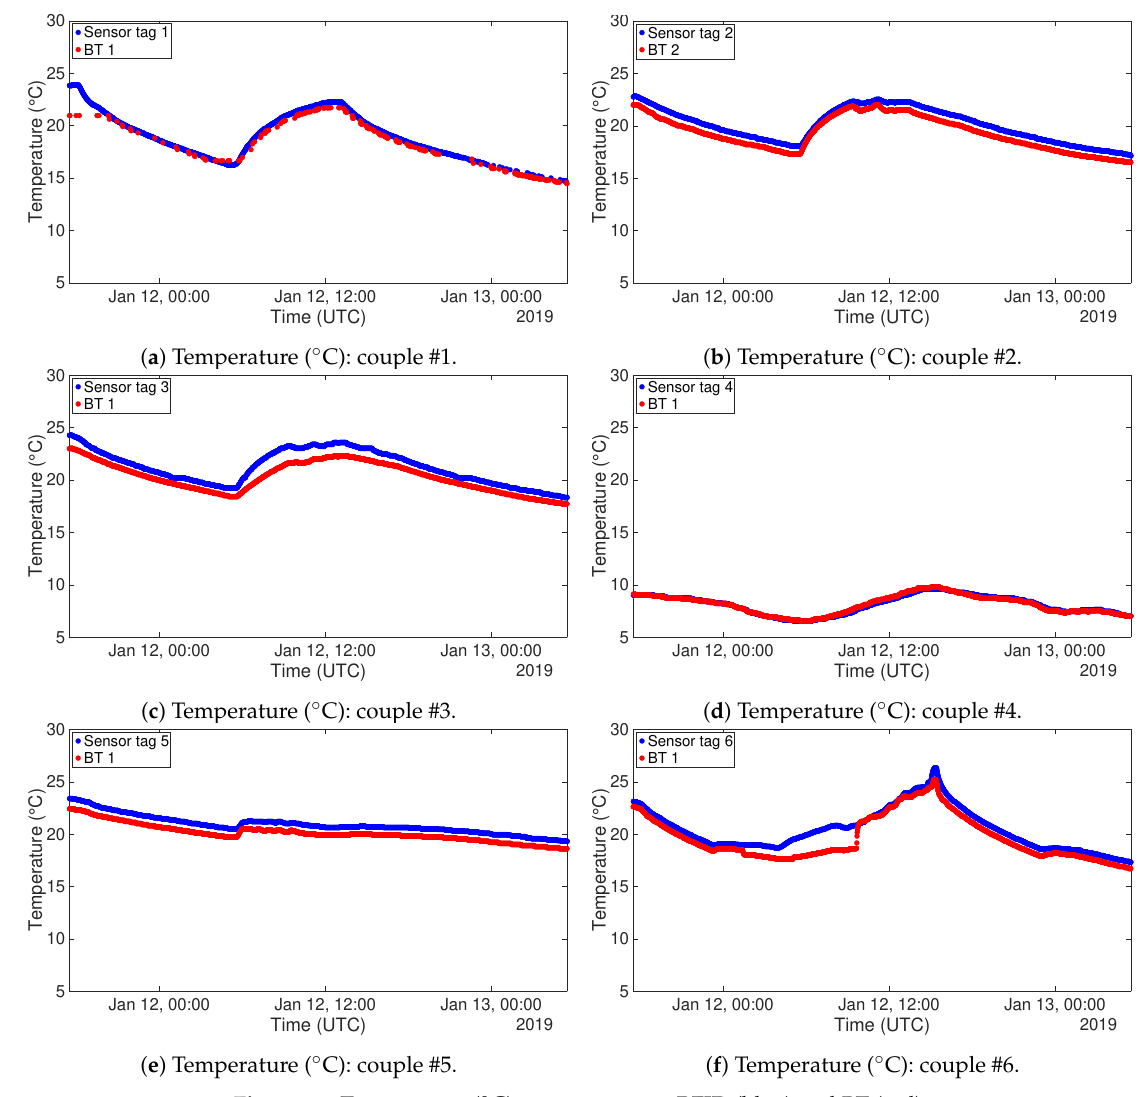
Figure 16. Temperature ( ◦ C) measurements: RFID (blue) and BT